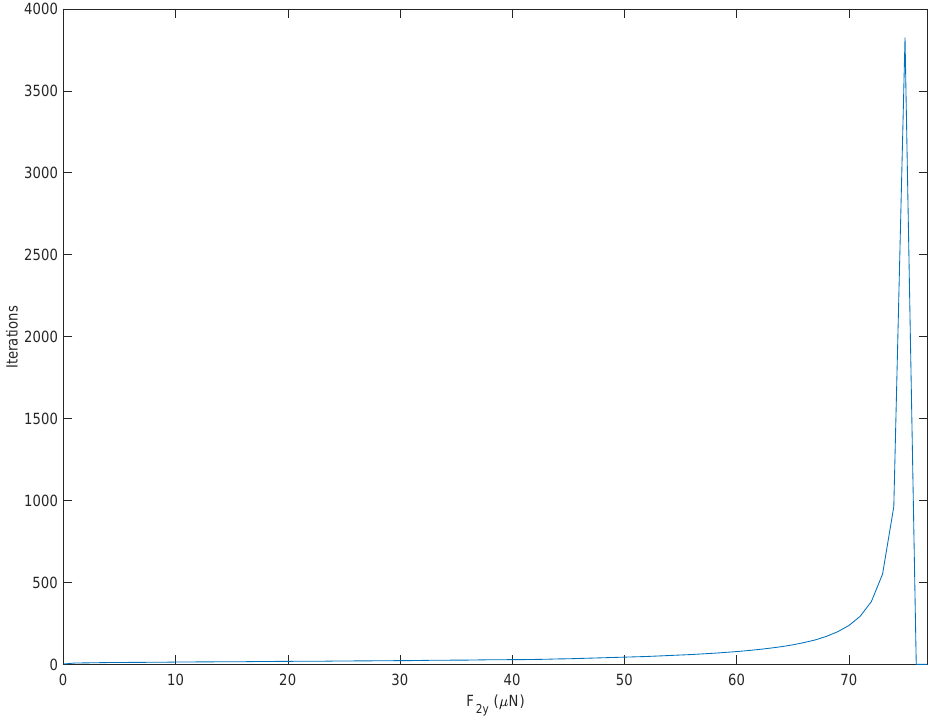
Figure 11. Number of iterations to achieve convergence of the direct kinetostatic analysis varying the input force. The simulation employs the constant tangent stiffness matrix obtained in the undeformed